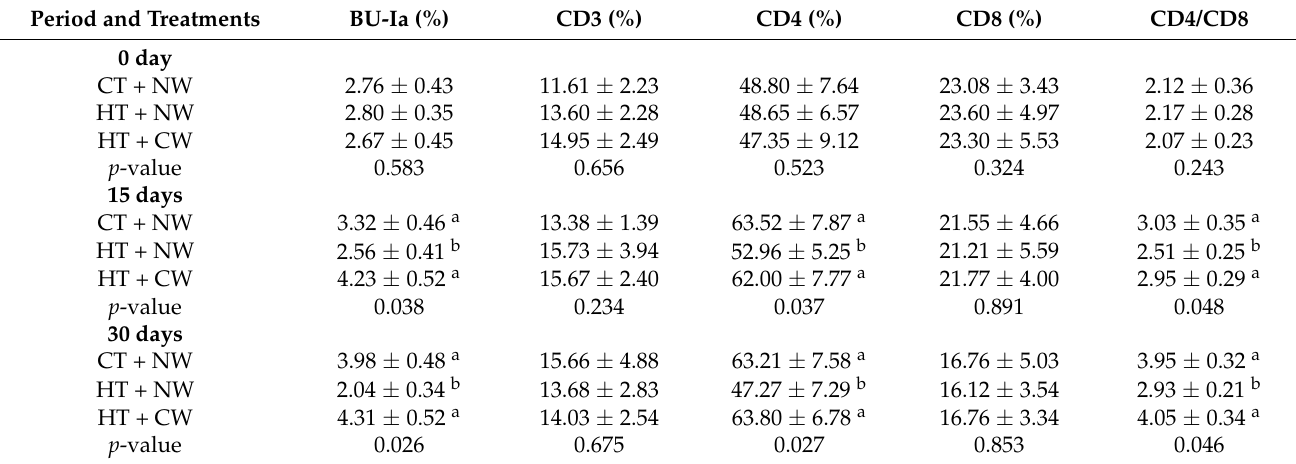
Table 4. Effects of cold drinking water on the contents of PBMC lymphocyte subsets in laying hens under heat